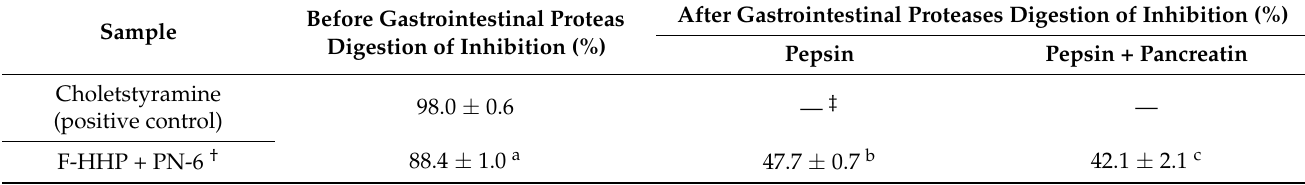
Table 3. Effect of digestion by gastrointestinal proteases on the inhibition against cholesterol micelle formation of F-HHP + PN-6